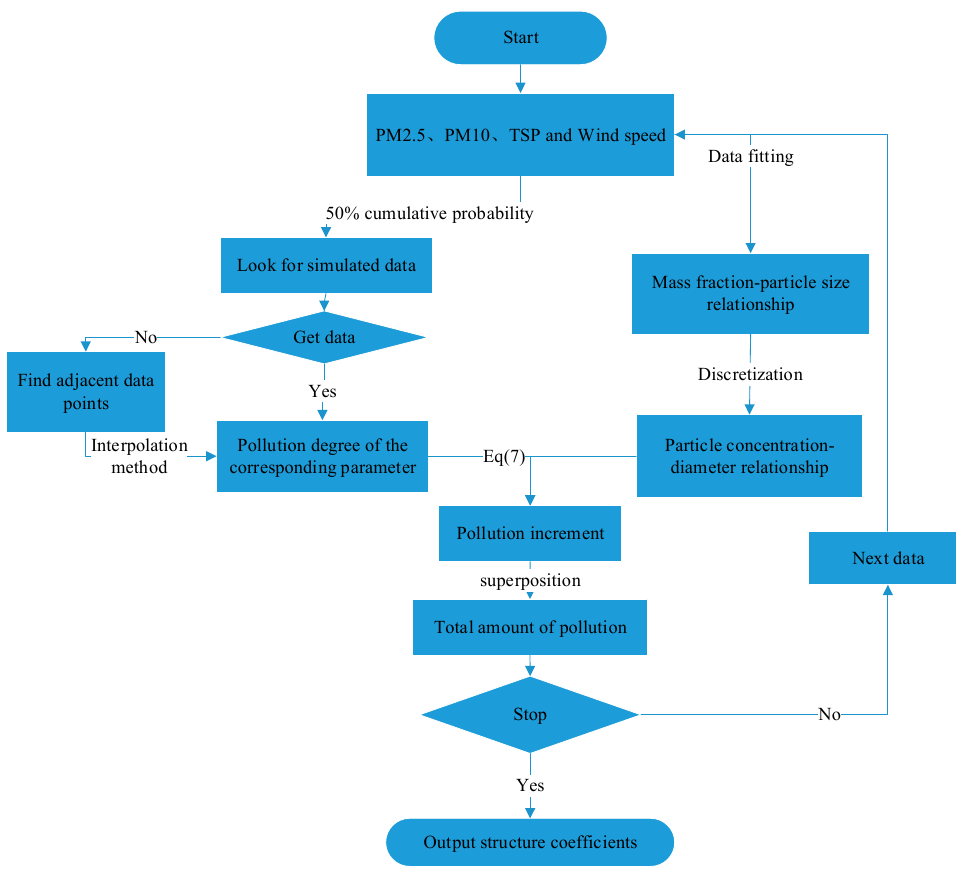
Figure 4. Flow chart of the pollution degree and the coefficients calculation.